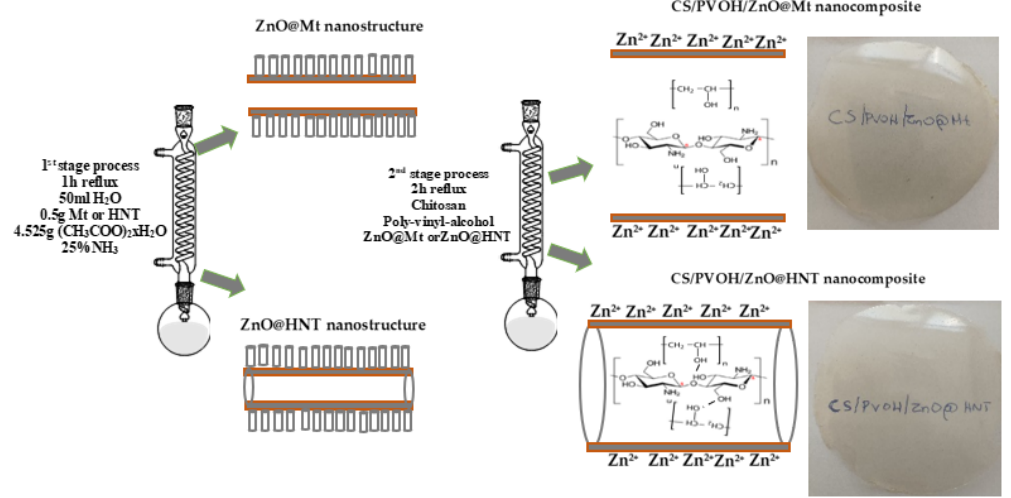
Figure 6. Illustration of the ZnO@Mt and ZnO@HNT nanohybrids and the formation process of the CS/PVOH/xZnO@Mt and CS/PVOH/xZnO@HNT intercalated nanocomposite films. Table 2. Calculated values of Young’s (E) modulus, ultimate tensile strength (_uts), and % strain at break (“b). Typical stress–strain curves for pure CS and CS/PVOH films as well as for CS/PVOH/xZnO@Mt and CS/PVOH/xZnO@HNT nanocomposite films are presented in Figure 3. The average values of the E modulus, tensile strength, and strain at break of all tested samples are provided in Table 2. It is obvious in Figure 7 that most of the tested